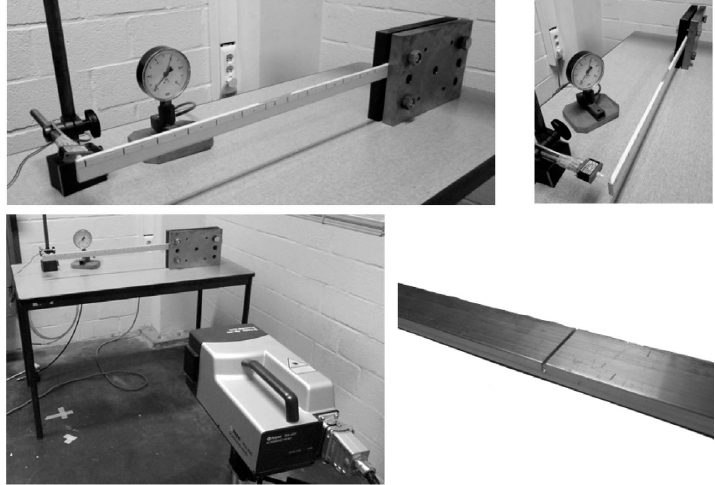
Fig. 26. Setup of the cantilever beam experiment with pneumatic excitation (top left), the use of the pneumatic excitation showing the valve and the nozzle (top right), measurement with laser Doppler vibrometer (bottom left), saw cut in aluminum beam (bottom right).